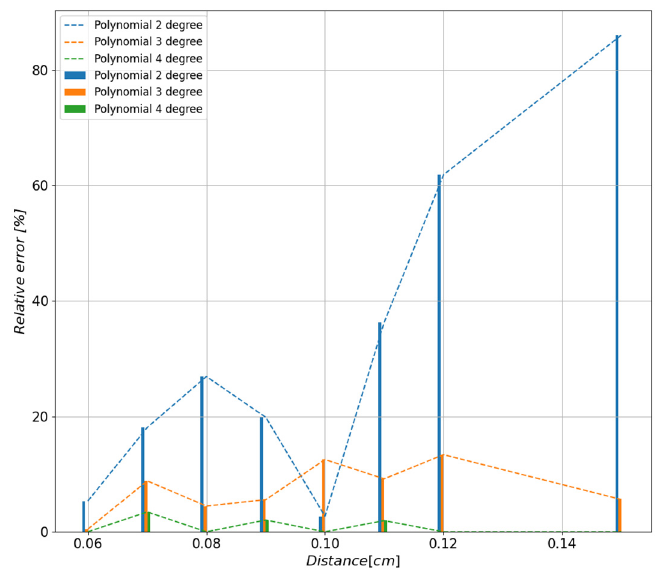
points; the relative error does not exceed 3.2%.